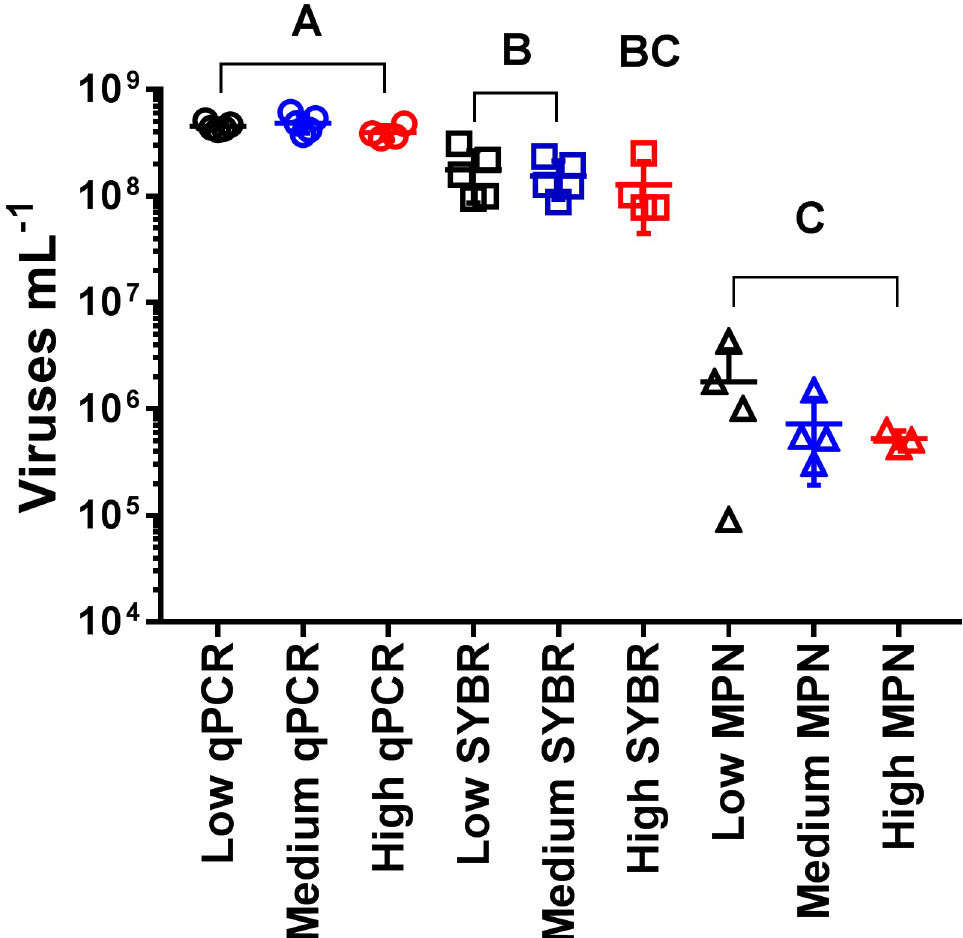
Fig 1. Comparison of three different methods to enumerate AaV. Epifluorescence microscopy with SYBR green, qPCR, and most probable number counts were used to enumerate virus concentration 13 days post infection of cultures acclimated to three different irradiance levels (high: 90 μ mol photons m -2 s -1 , medium: 60 μ mol photons m -2 s -1 , and low: μ mol photons m -2 s -1 ). Letters represent statistically indistinguishable concentrations (two-way ANOVA; see Methods and S1 Table).